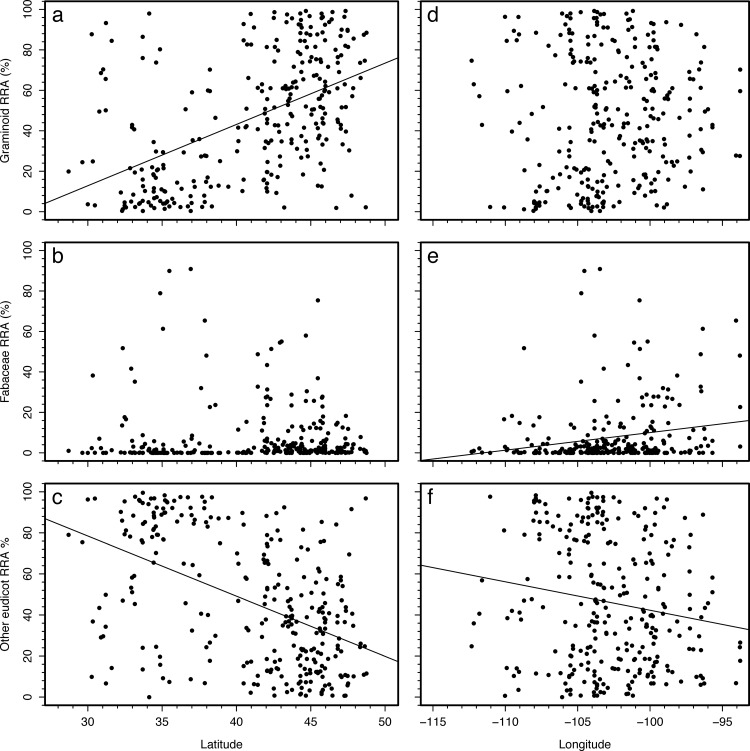
Geographic patterns of the abundance of functional groups in diets.Latitudinal and longitudinal patterns of (a,d) graminoids, (b,e) species in the Fabaceae family, and (c,f) other eudicots. Percentages expressed relative to the sum of the relative read abundances of the top 50 OTUs. Significant (P < 0.05) bivariate linear relationships shown. Regression results include a) r2 = 0.26, P < 0.001; c) r2 = 0.23, P < 0.001; e) r2 = 0.04, P < 0.001; and f) r2 = 0.03, P = 0.004.